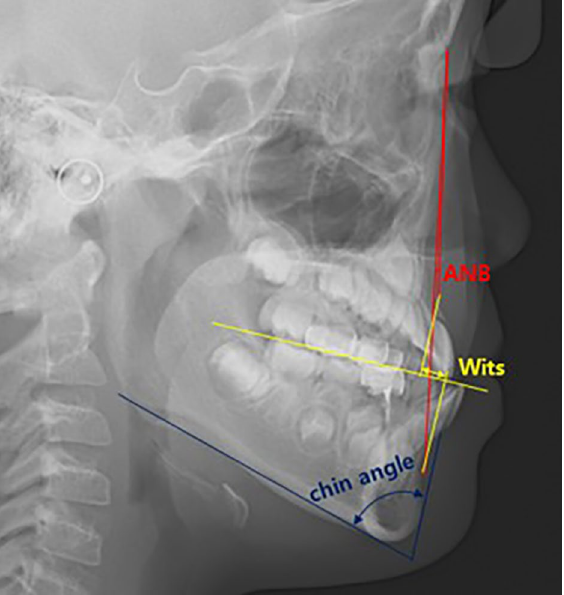
Figure 2. Cephalometric analysis used for the present study. ANB, point A-Nasion-point B angle; Wits appraisal, distance between the lines drawn from points A and B, perpendicular to the occlusal plane; chin angle, angle formed between the line passing through interdentale of lower incisors and pogonion and the mandibular